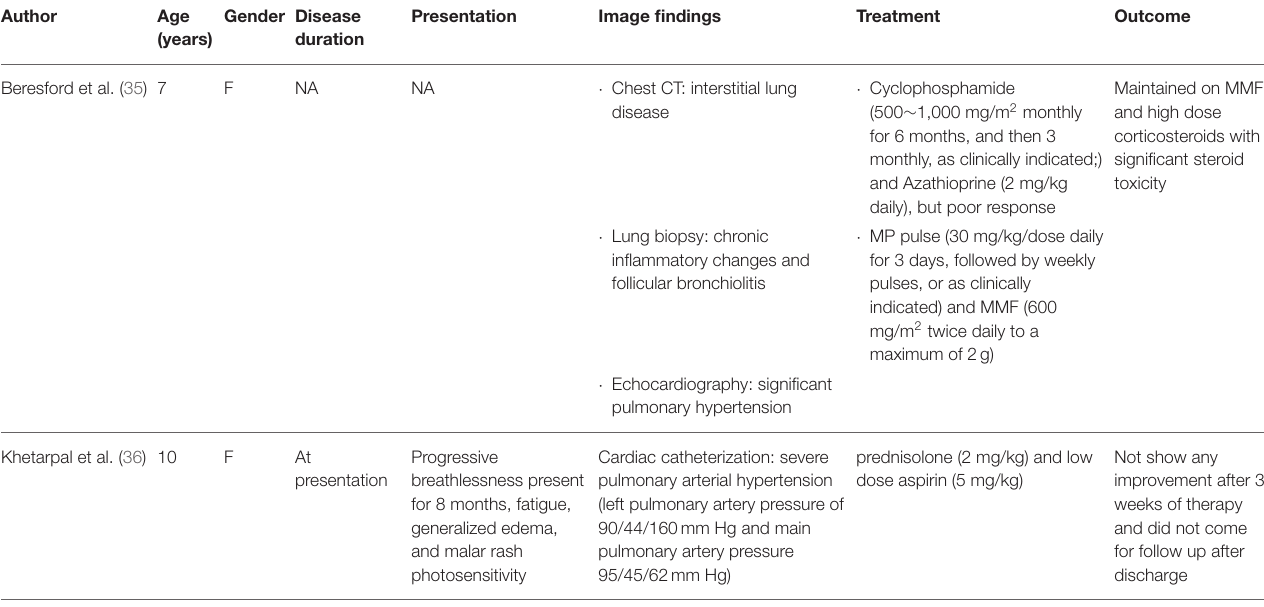
TABLE 2 | Previous case reports of pulmonary hypertension in patients with pediatric